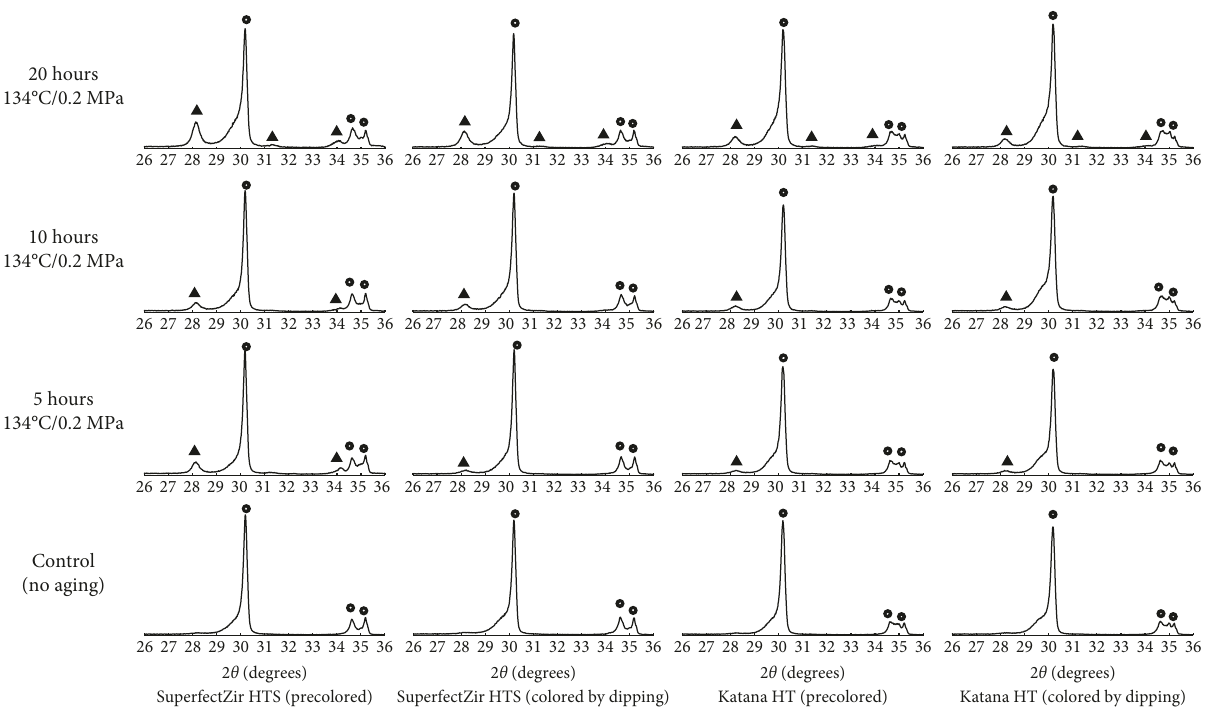
Figure 1: XRD patterns of the materials tested ( , monoclinic phase; , tetragonal